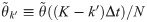
Pseudocode for the update of the variables of a given population.Note that the adaptation kernel θk′ ≡ θ((K − k′)Δt), the quasi-renewal kernel θ˜k′≡θ˜((K-k′)Δt)/N, Eq (33), as well as the exponentials e-Δtτm and Jθ,ℓe-KΔt/τθ,ℓ can be precomputed.